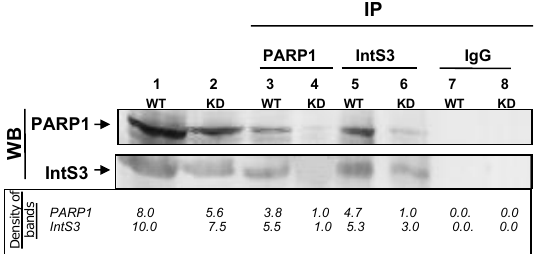
Figure 1. PARP1 and IntS3 associate in vivo in drosophila S2 cells. In WT cells (Lane 2), immuno- precipitation of PARP1 pulled down IntS3 as a direct interactor (Lane 3). In reciprocal experiments, immunoprecipitation of IntS3 pulled down PARP1 as an interactor (Lane 5). Knockdown of PARP1 (Figure S1) reduces the PARP1 – IntS3 complex (Lane 4), but not IntS3 levels. Therefore, when the very little PARP1 caused by knockdown is bound to the beads, little IntS3 is pulled down in a corresponding level. On the other hand, since knockdown of PARP1 does not affect IntS3 levels, the higher level of IntS3 bound to the beads pulled down whatever PARP1 remained in the knockdown conditions (Lane 6). No immunoprecipitation was seen from IgG controls for either WT or KD cells (Lanes 7 and 8, respectively). Image Quant TL software was used to quantify band density (back- ground subtracted), as shown below the Western blot image.